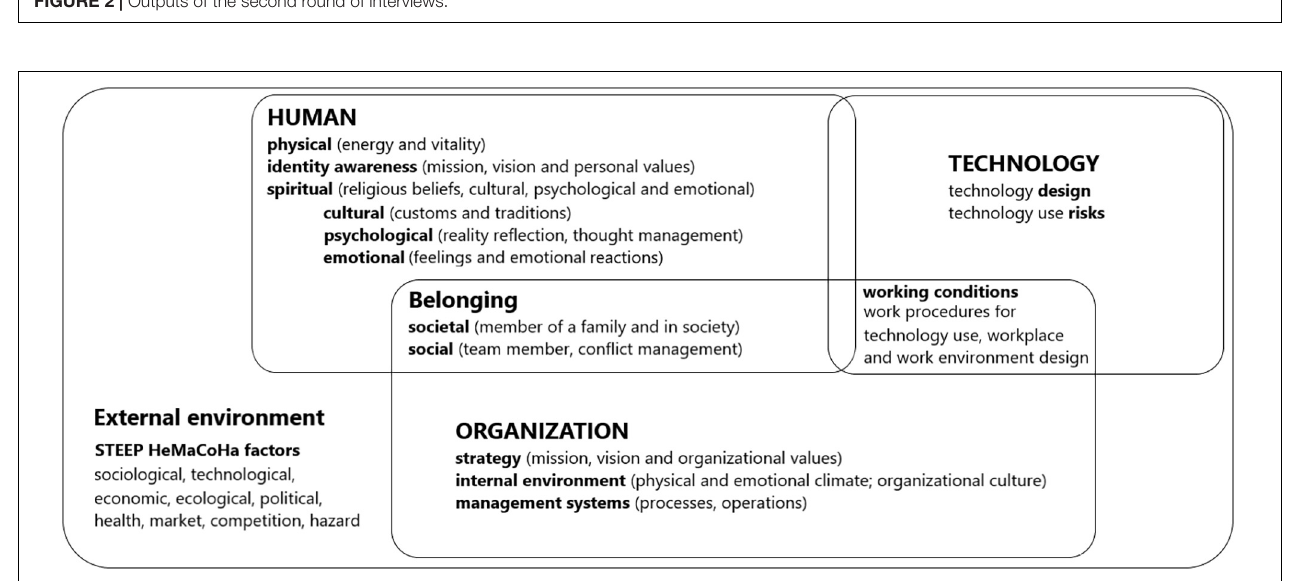
FIGURE 3 | The human capital valorization (HCV)